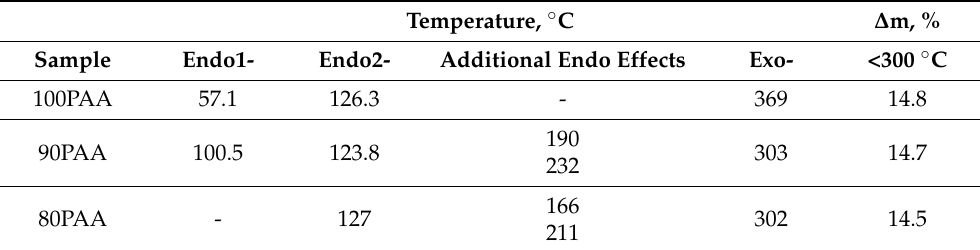
Table 1. The types and temperatures of the effects according to the DTA curves and mass losses calculated from the TG curves of 100PAA, 90PAA and 80PAA samples. Temperature, ◦ C ∆ m,